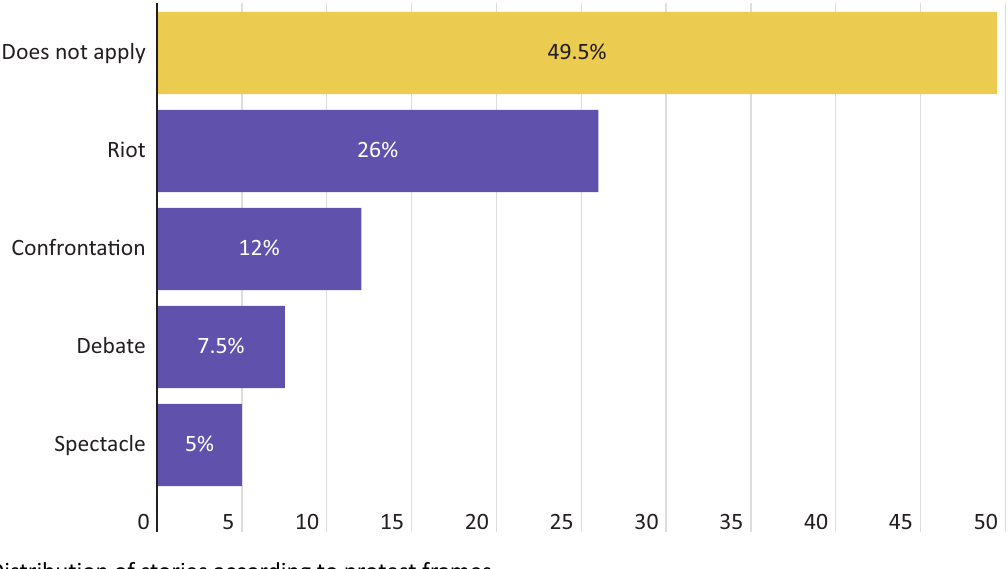
Figure 1. Distribution of stories according to protest frames.